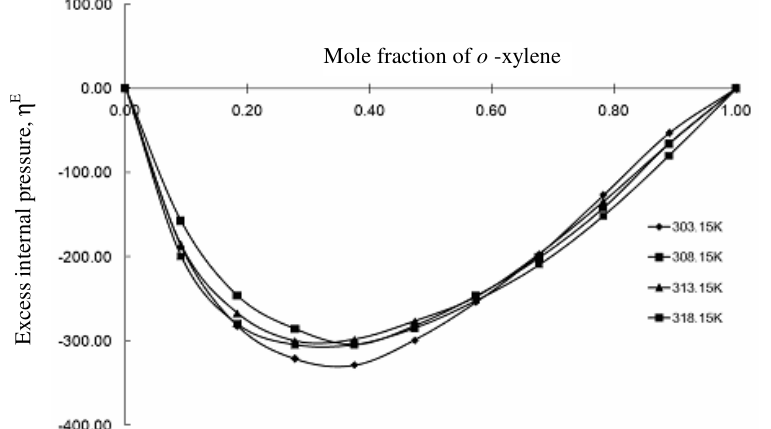
Figure 6. Variation of excess internal pressure with mole fraction at different